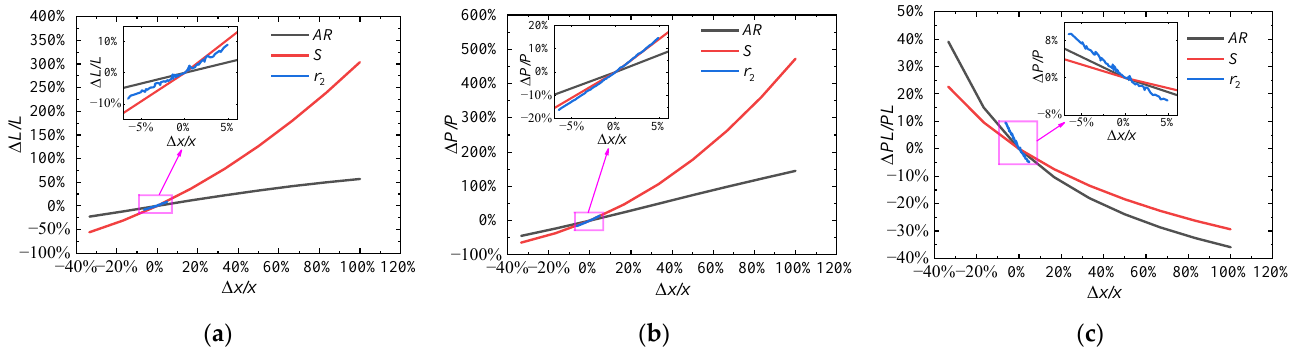
Figure 16. Comparison of sensitivity analysis results for the geometric parameters. ∆ x is the variation of the corresponding independent variable, e.g., ∆ S for S . ( a ) Sensitivity of lift. ( b ) Sensitivity of aerodynamic power. ( c ) Sensitivity of power loading. Table 8. Comparison of the exponent a of different sensitivity parameters at 28 Hz.